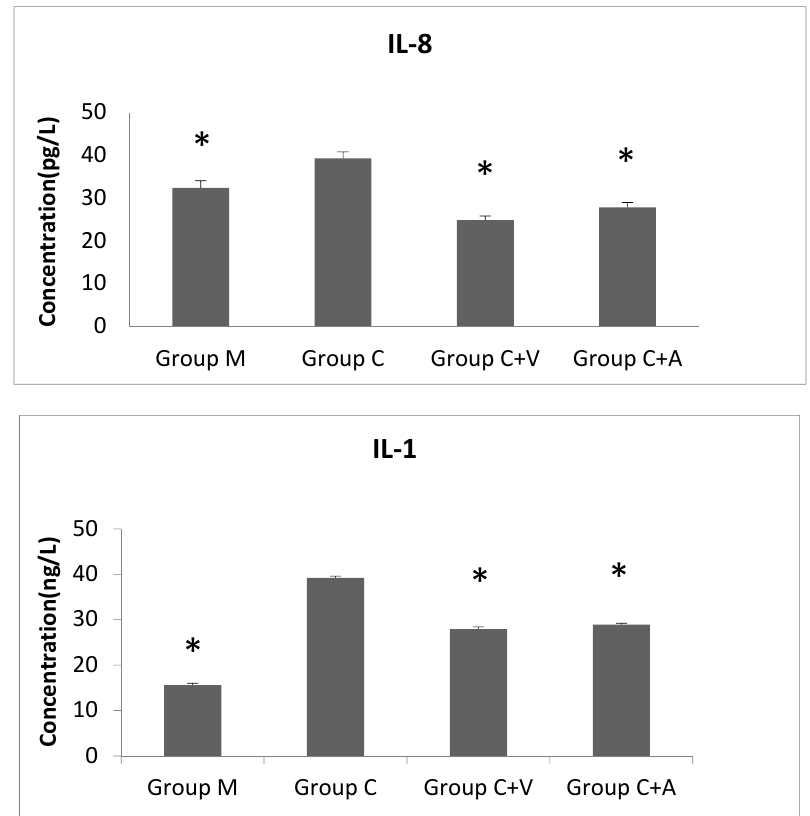
Figure 4. IL-8 and IL-1 production for four groups after 48 h of incubation. The experiment was repeated three times and the results are shown as mean with standard deviation. * Statistically significant difference compared with Group C by the Paris t -test ( p = 0.000). Group C + A, the azithromycin-treated group. Group C + V, the Vp1-treated group. Group C, the Chlamydia trachomatis group. Group M, the blank group (only McCoy cells).